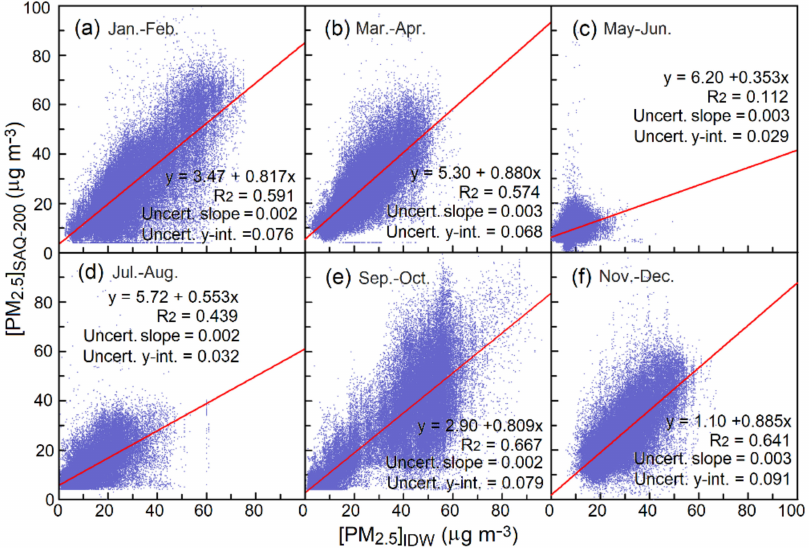
Figure 5. Same as in Figure 4, but the observed PM 2.5 concentrations ([PM 2.5 ] SAQ-200 ) were from the SAQ-200 sensors in